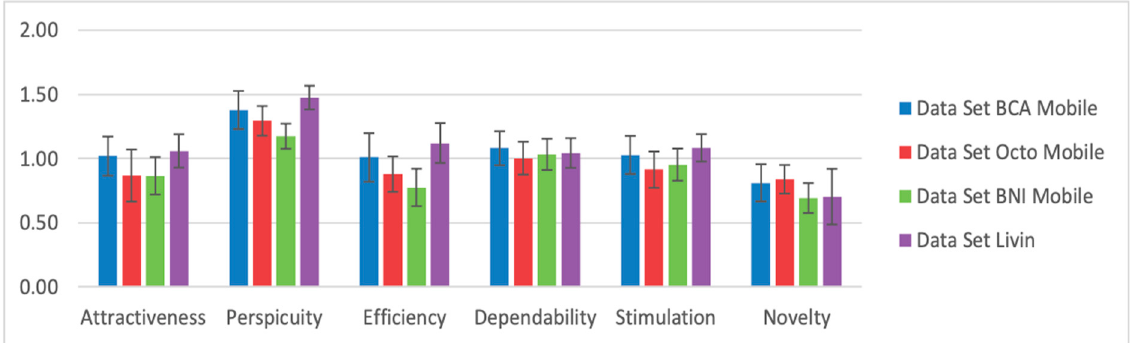
Figure 5. UEQ comparison on the mobile banking application.